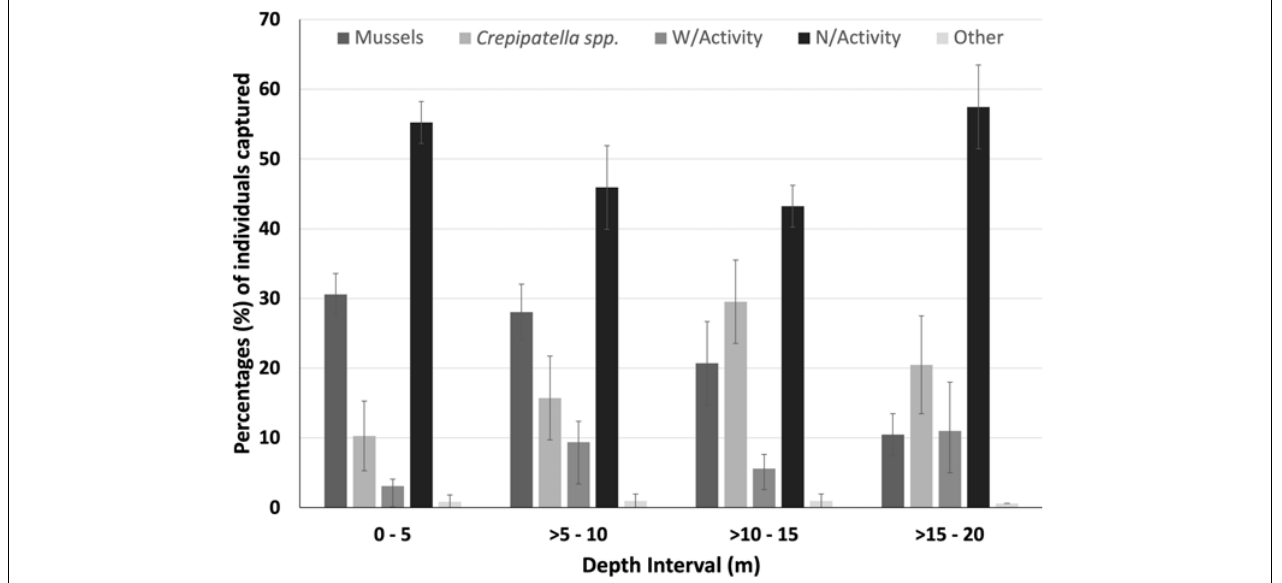
FIGURE 6 | Five categories of feeding activity of the sea star Cosmasterias lurida in Yerbas Buenas Bay: 1, feeding on mussels; 2, feeding on Crepipatella spp.; 3, with activity (W/activity; stomachs out but no associated prey); 4, no activity (N/activity); and 5, feeding on other prey species. No sea stars were observed feeding below 20 m in depth. Bars represent standard